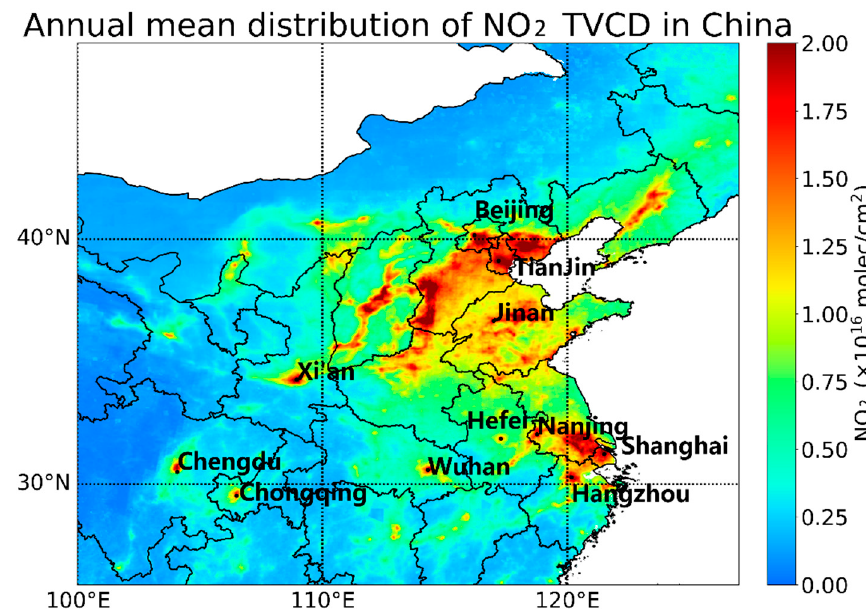
Figure 1. Annual mean distribution of NO 2 TVCD in